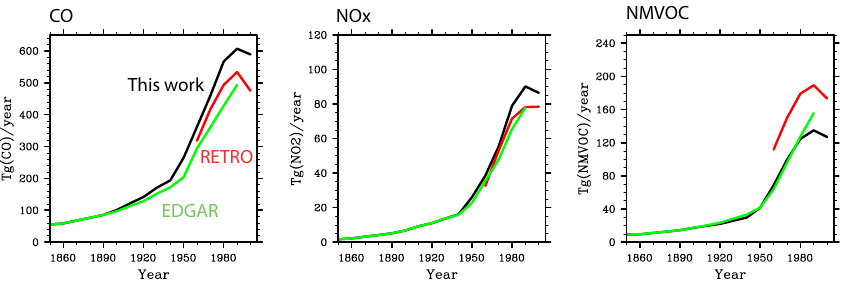
Fig. 1. Time evolution of the total (sum of all sectors but agricultural waste burning) land anthropogenic emissions for CO (Tg(CO)/year), NO x (Tg(NO 2 )/year) and total NMVOC (Tg(NMVOC)/year).